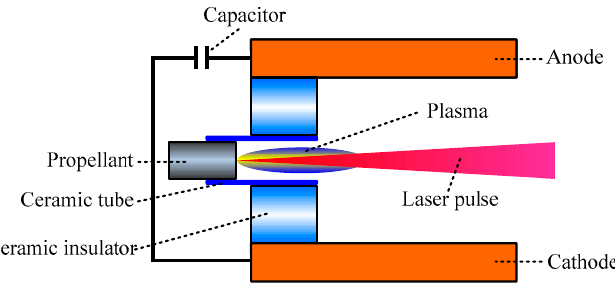
Figure 1. Schematic diagram of modified laser-assisted pulsed plasma thruster.